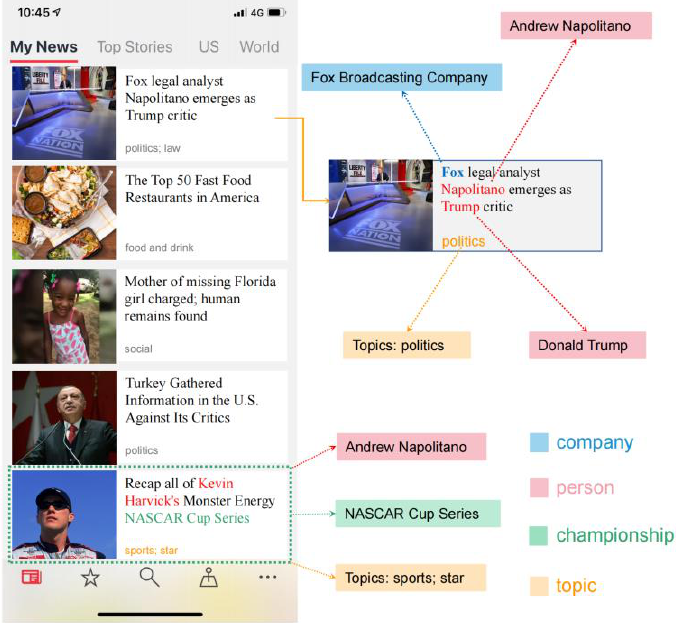
Figure 1. Illustration of news title with a variety of entities and topics.